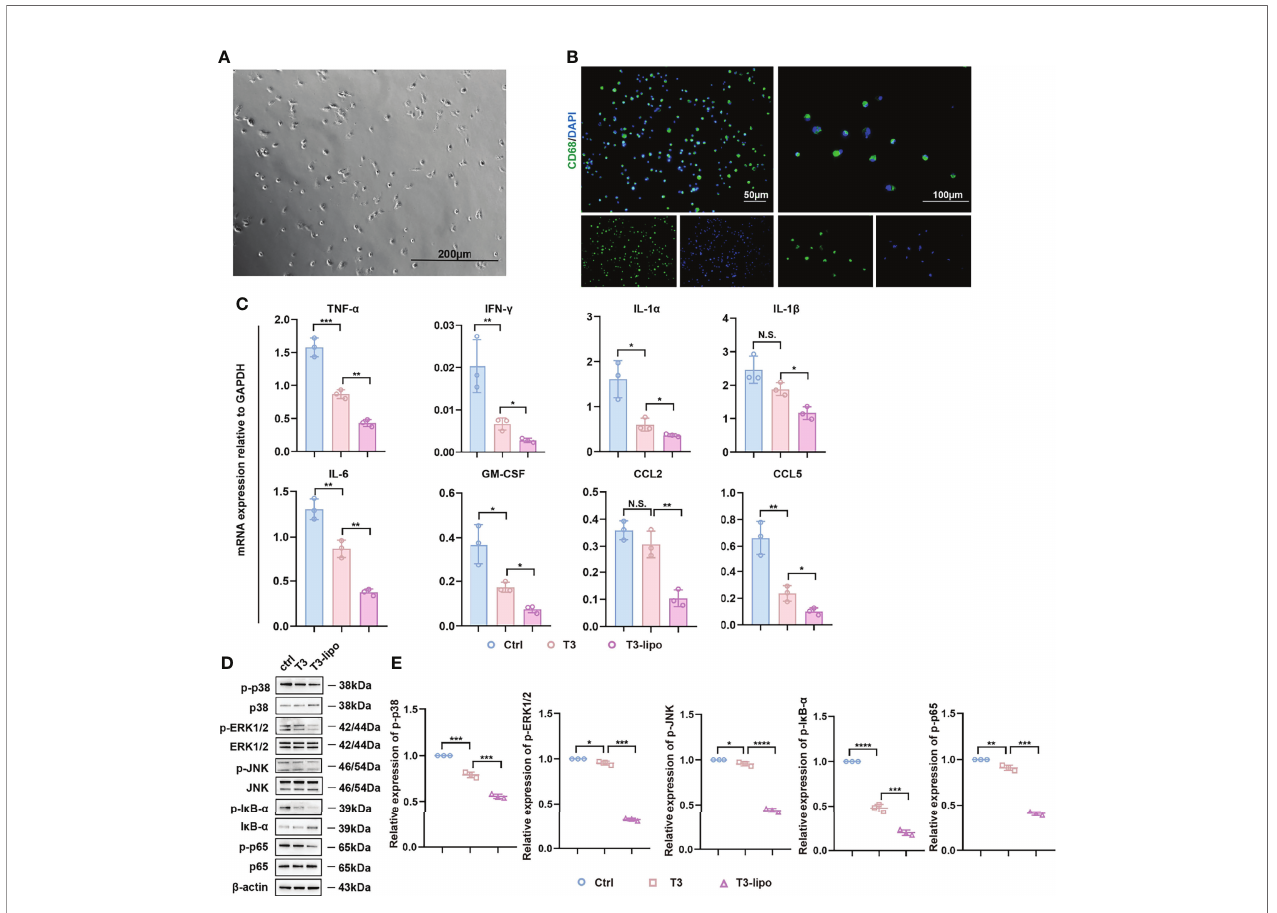
FIGURE 5 | Anti-in fl ammatory effect of T3-lipo on hepatic macrophages in vivo . (A) The image of primary hepatic macrophages by microscope. (B) The immuno fl uorescence image of staining for CD68. (C) RT-PCR analysis of TNF- a , IFN- g , IL-1 a , IL-1 b , IL-6, GM-CSF, CCL2, and CCL5 mRNA in hepatic macrophages of DEN-induced rats treated with saline, T3 or T3-lipo. (D) Western blotting assay of MAPK and NF- k B signaling pathways in hepatic macrophages of DEN-induced rats treated with saline, T3, or T3-lipo. (E) Densitometry of p-p38, p-ERK1/2, p-JNK, p-I ĸ B- ɑ , and p-p65 was performed followed by normalization. Mean ± SD values were obtained from at least three independent experiments performed in triplicate. Differences were analyzed using One-way ANOVA (*p < 0.05, **p < 0.01, ***p < 0.001, and ****p < 0.0001; N.S., not signi fi